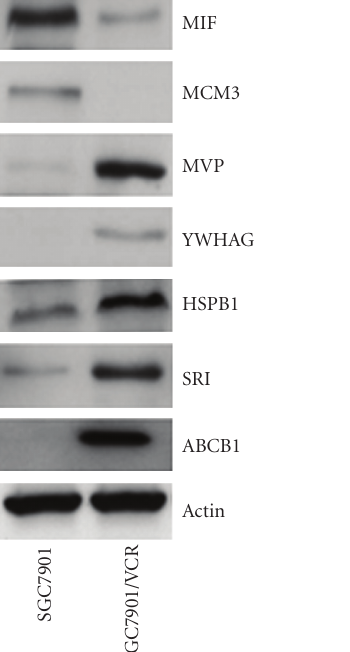
Figure 3: A representative Western blot analysis result of SRI, ABCB1, HSPB1, YWHAG, MVP, MCM3, and MIF expression in the two cell lines. Compared with SGC7901, vincristine-resistant SGC7901/VCR had an obvious up-regulation of SRI, ABCB1, HSPB1, YWHAG, and MVP, and a marked down-regulation of MCM3 and MIF.